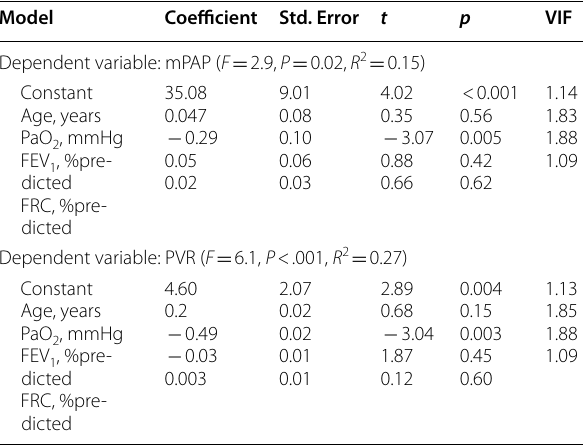
Table 3 Regression models predicting mPAP and